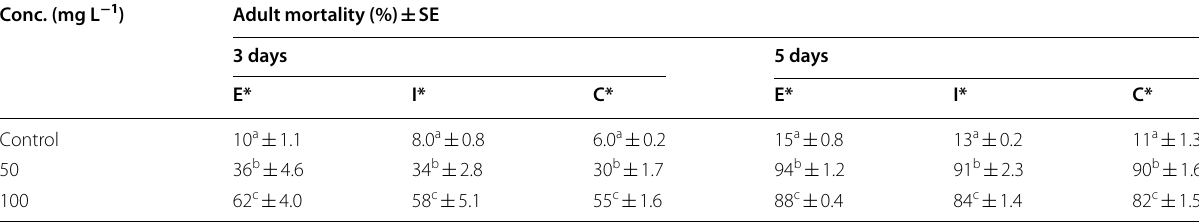
Means followed by the same letter in the same column are not significantly different according to Tukey’s multiple range test at P < 0.05